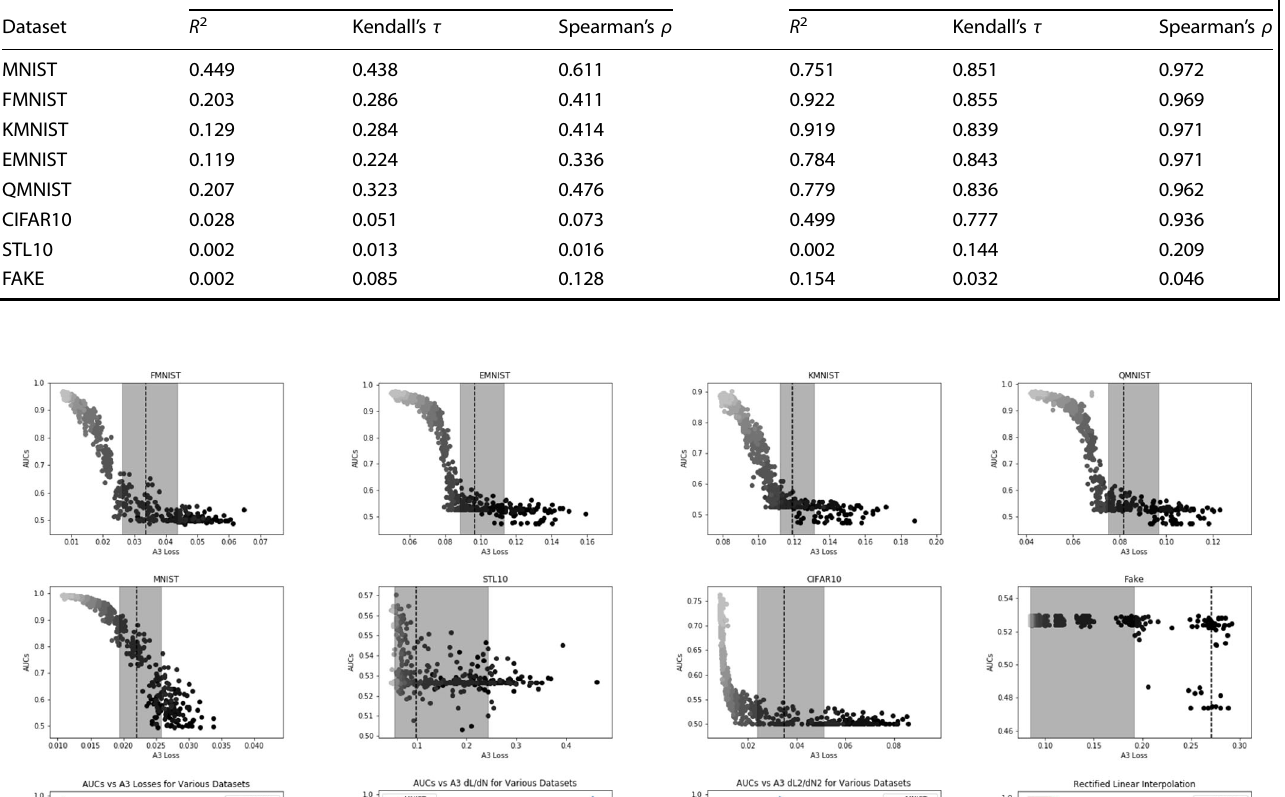
Table 1. Comparison of statistical power above and below auto-encoder loss in fl ection points for various image datasets. Pre-MCSE